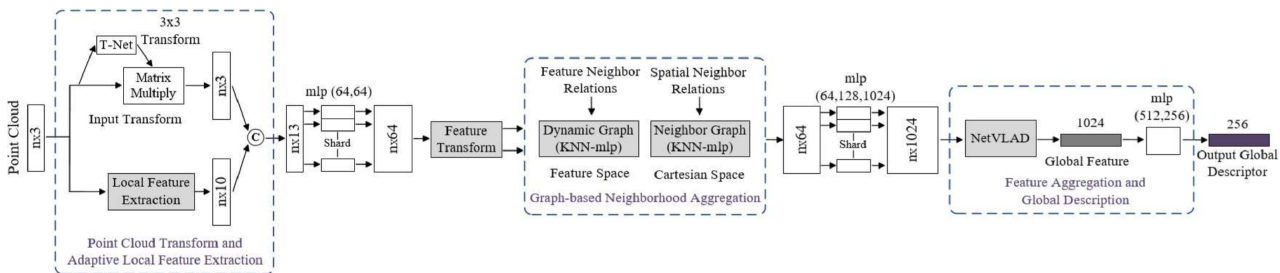
Figure 30. The LPD-Net [83] for large scale place recognition.